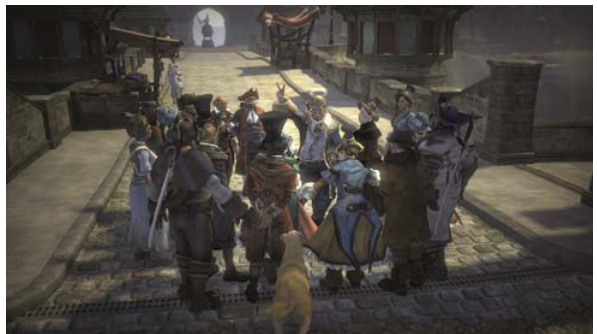
Figure 2. Screenshot of Fable 2. The dynamic character development has a central significance